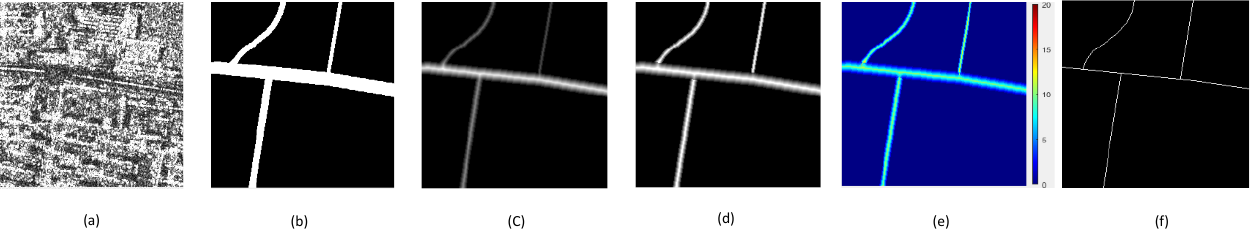
Figure 2. ( a ) SAR image I . ( b ) ground truth Y . ( c ) distance map D . ( d ) normalized distance map D N . ( e ) discrete normalized distance label L . ( f ) Centerline C